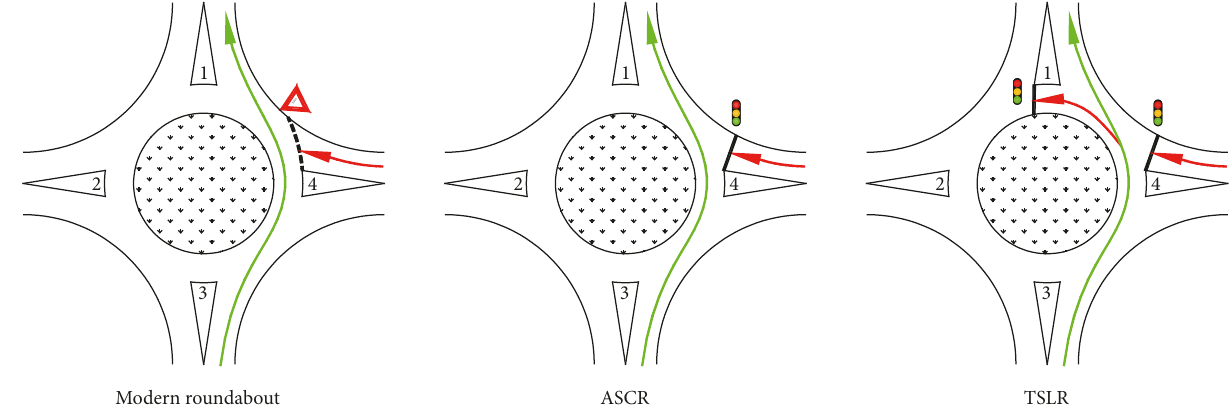
Figure 2: The schematic diagram of modern roundabout, ASCR, and